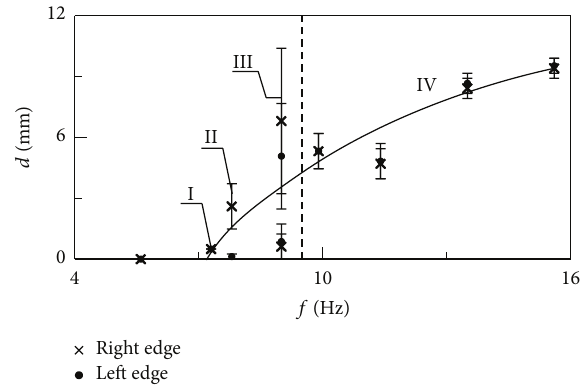
Figure 10: Regimes of the body behavior versus the vibration frequency, 𝑏 = 34.6 mm, ] = 1.04